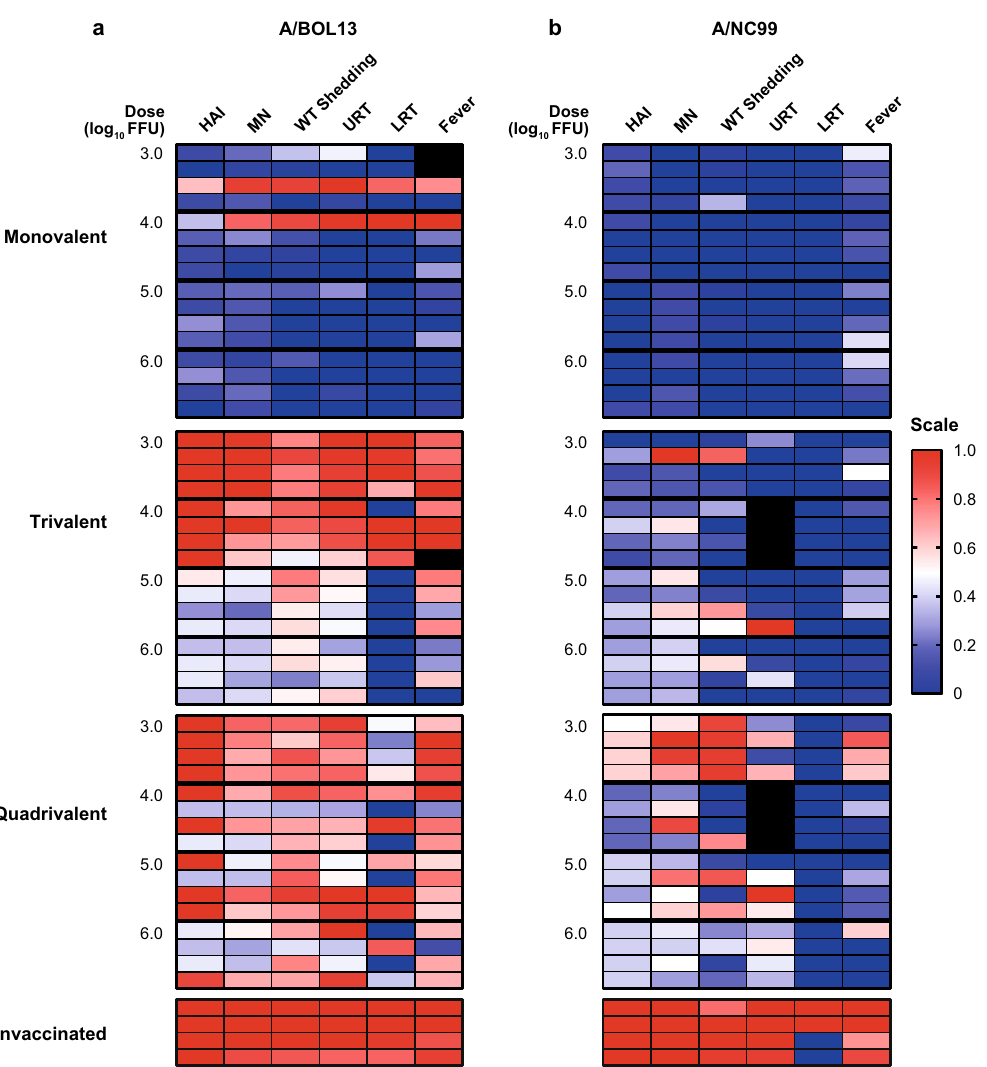
Fig. 6 Summary of endpoints demonstrates reduction in A/BOL13 ef fi cacy in multivalent formulations relative to A/NC99. Data from multiple endpoints for A/BOL13 a and A/NC99 b vaccine groups were expressed as heatmaps. Each panel shows a single vaccine formulation (top to bottom: monovalent, trivalent, and quadrivalent LAIV, and unvaccinated). Each row represents an individual ferret, with four animals per dose group, with vaccine doses ordered from 3.0 (top) to 6.0 log 10 FFU (bottom). Endpoints shown are, left to right: HAI titer; MN titer; geometric mean wt virus shedding (Days 1 – 3, TCID 50 ); wt virus titer in NT tissue (TCID 50 ); wt virus titer in lung tissue (RT-qPCR); fever (°C). All endpoints, irrespective of units of measurement, were normalized to a uniform 0 – 1 scale. Immune responses and protection equivalent to the average of the 6.0 log 10 FFU monovalent vaccine group were calibrated to 0 (navy blue). Immune responses and protection equivalent to average data from unvaccinated controls were calibrated to 1 (red). White cells indicate mean of red/navy blue. Gray cells indicate